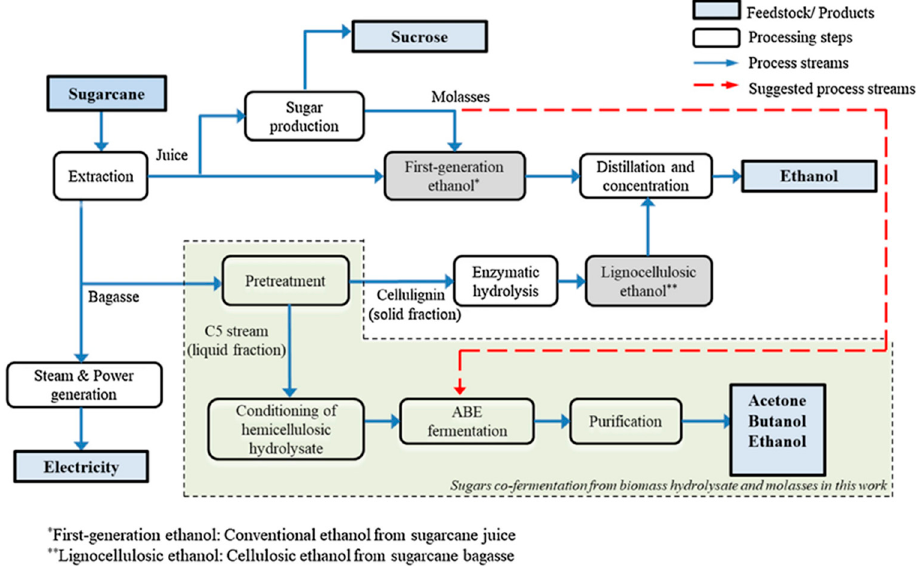
Figure 4. Proposed sugarcane biorefinery process(es) to produce sucrose, power, and fuels/solvents. Reproduced with permission from Zetty-Arenas A, et al. [174], Copyright 2021, Elsevier.